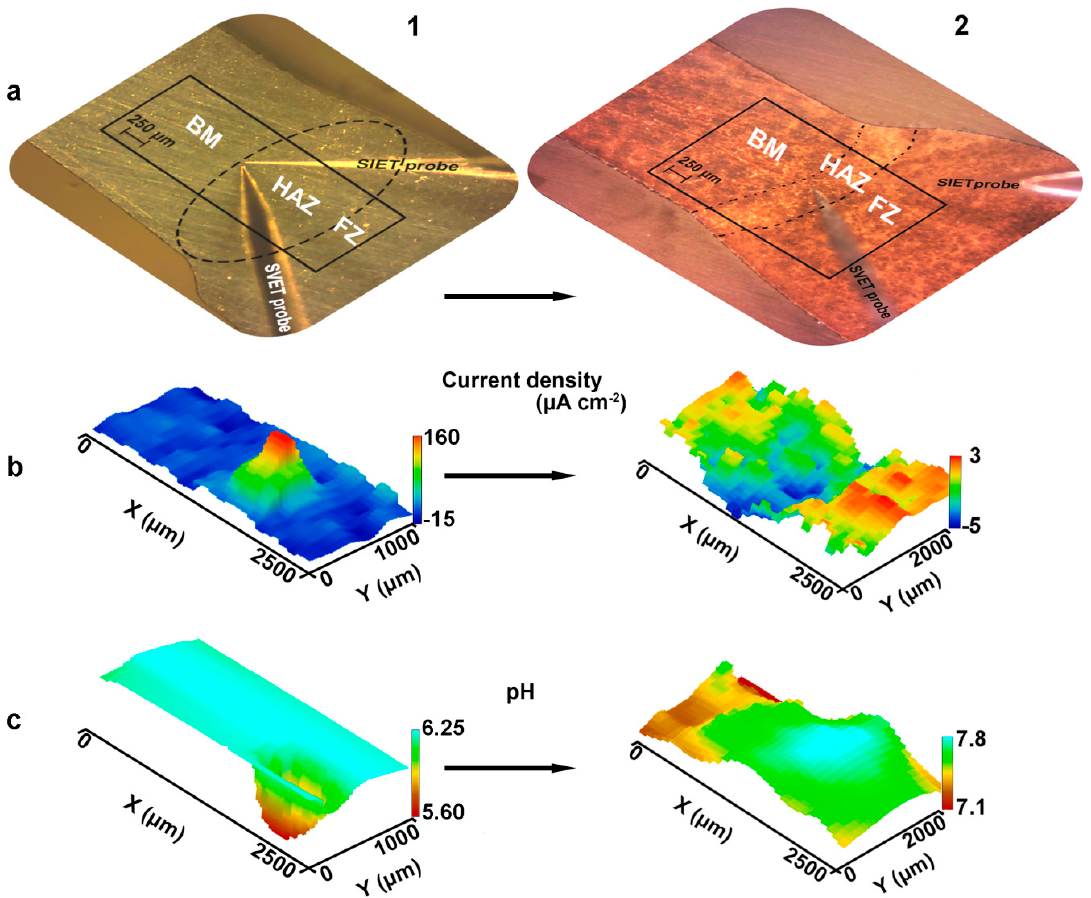
Figure 13. The optical image ( a ), SVET ( b ) and SIET ( c ) 3D maps of the studied welded joint area including BM, HAZ, and FZ for the sample without ( 1 ) and with PEO-coating ( 2 ). SVET and SIET maps presented after 8 h of sample exposure to 3% NaCl